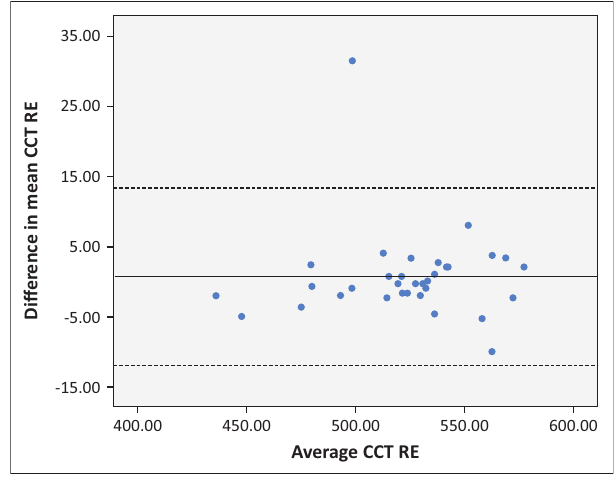
CCT RE, central corneal thickness Right Eye. FIGURE 3: Bland–Altman plot comparing iVue-100 spectral domain optical coherence tomographer central corneal thickness measurements of 33 eyes by observer one in two separate sessions. The solid line represents the mean difference (0.626 µ m ± 6.449 µ m) and the dashed lines represent the two limits of agreement (13.27 µ m; -12.01 µ m).